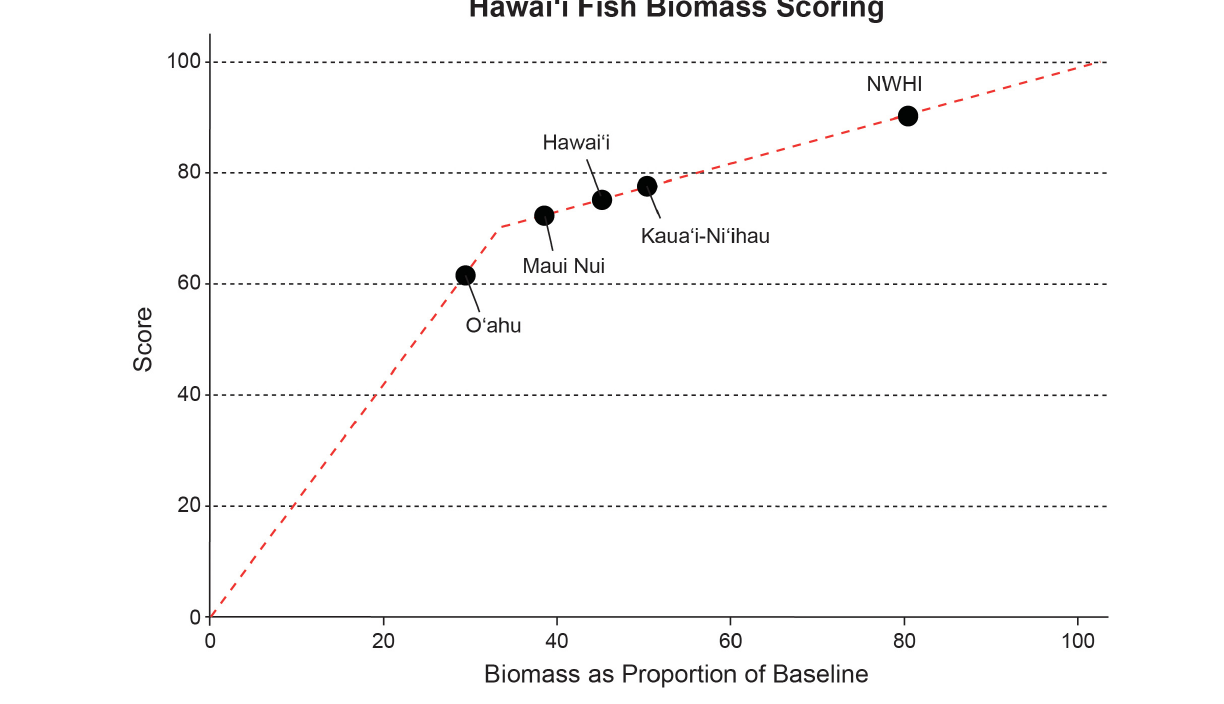
Frontiers in Marine Science |